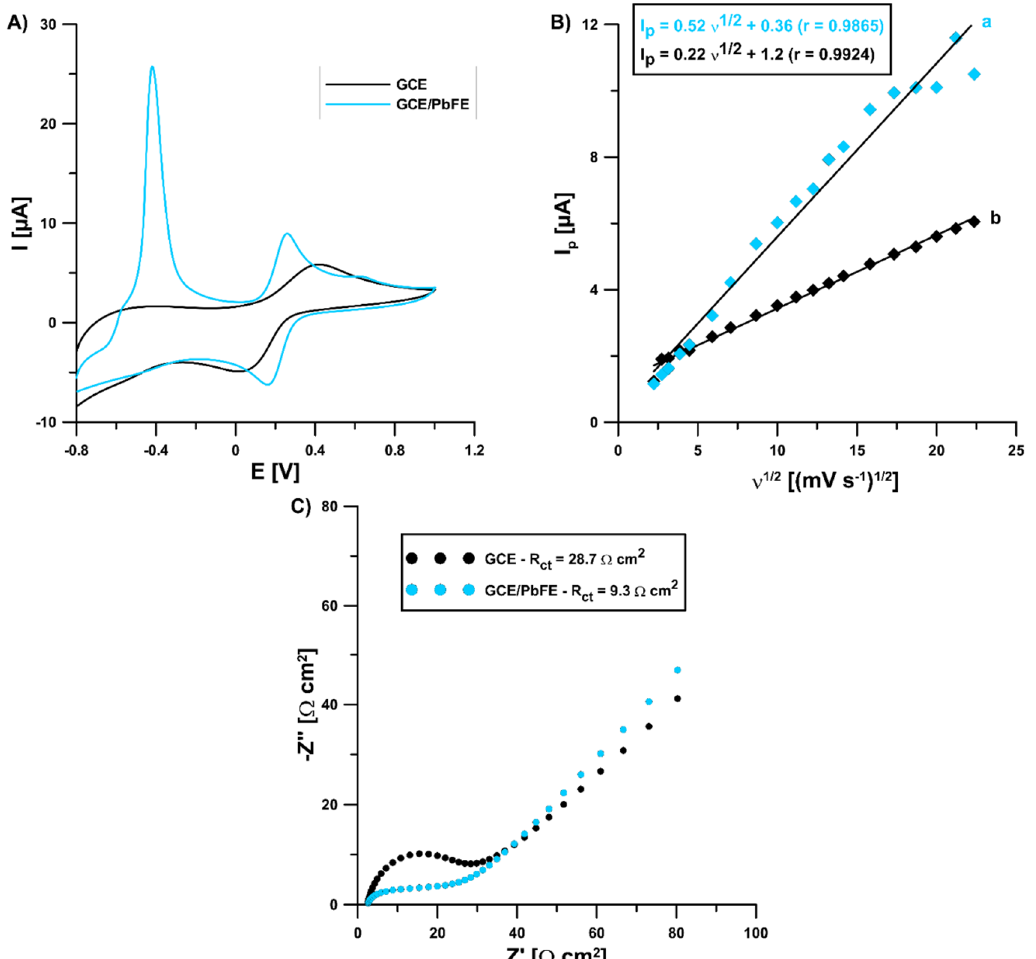
Figure 5. ( A ) CVs obtained at a bare GCE and GCE/PbF using the υ of 100 mV s − 1 ; ( B ) the dependence between the anodic peak current (I p ) and the square root of the υ ( υ 1/2 ) at the GCE (b) and GCE/PbF (a); ( C ) Nyquist plots of the GCE and GCE/PbF.